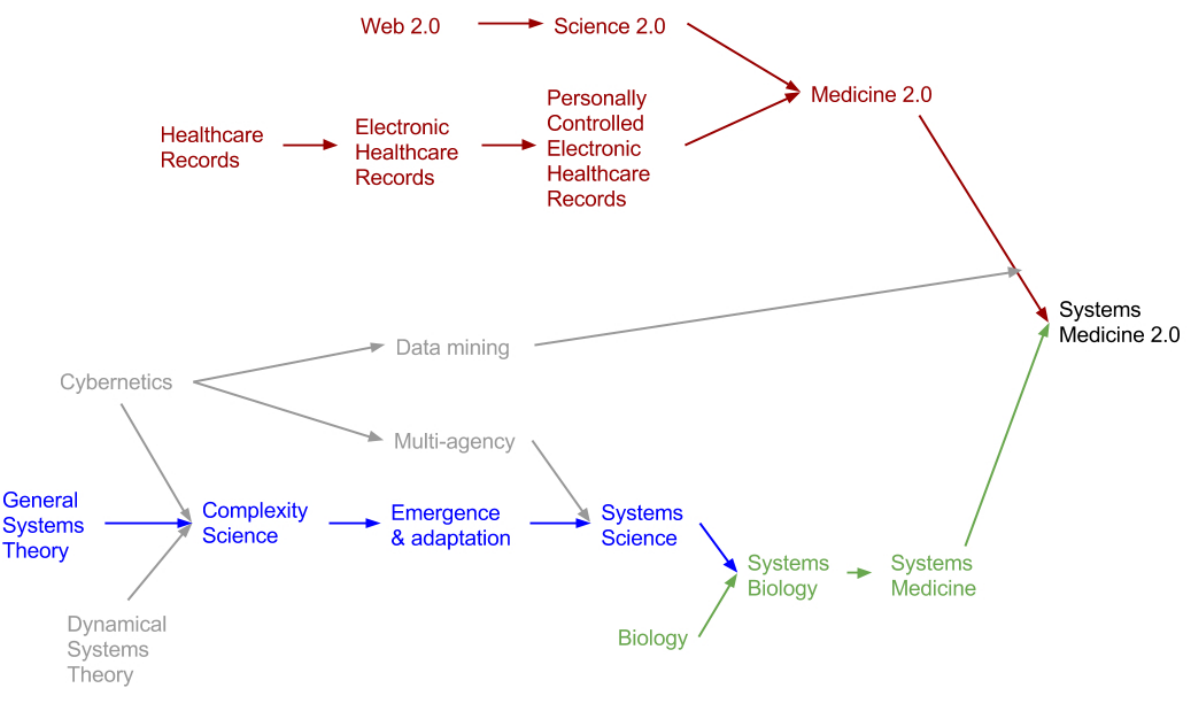
Figure 3. The historical origins of “Systems Science” and “Medicine 2.0”, and the potential for their combination into “Systems Medicine